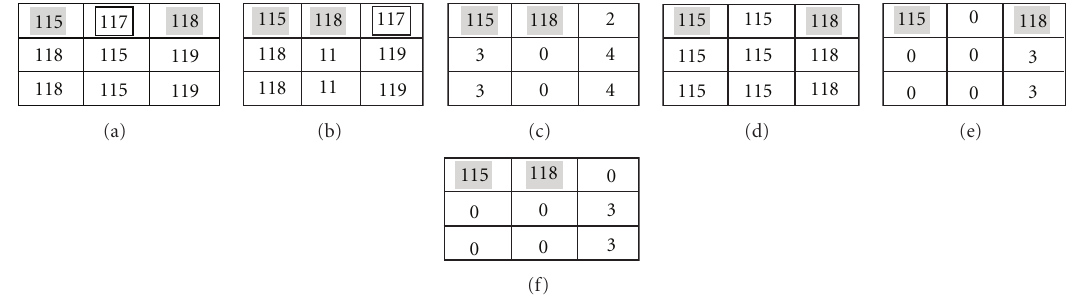
Figure 2: Example of data extraction. (a) The stego-block 2, (b) after the adjustment of the maximum pixel value, (c) the di ff erence block, (d) the host block restored from the stego-block 1, (e) the di ff erence block of (d), and (f) after adjustment the maximum pixel value. The hidden digits can be extracted by subtracting the coe ffi cients in (c) from those in (f); respectively, the extracted digits was (103 103 2) 4 .